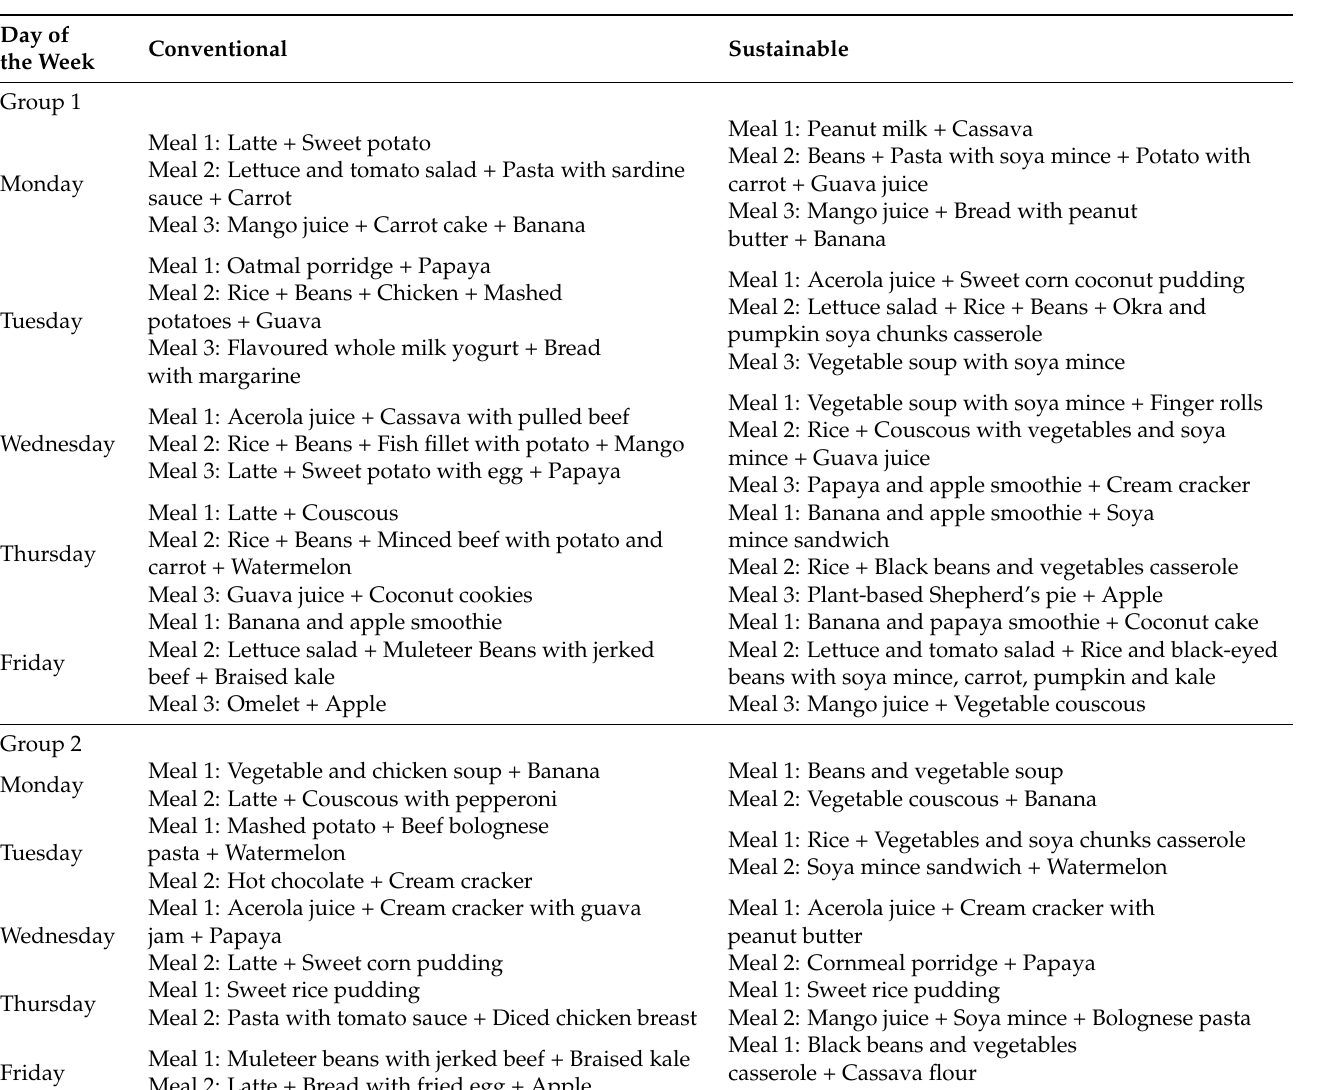
Table 1. Conventional and sustainable weekly menus, according to age group, selected for this analy- sis.